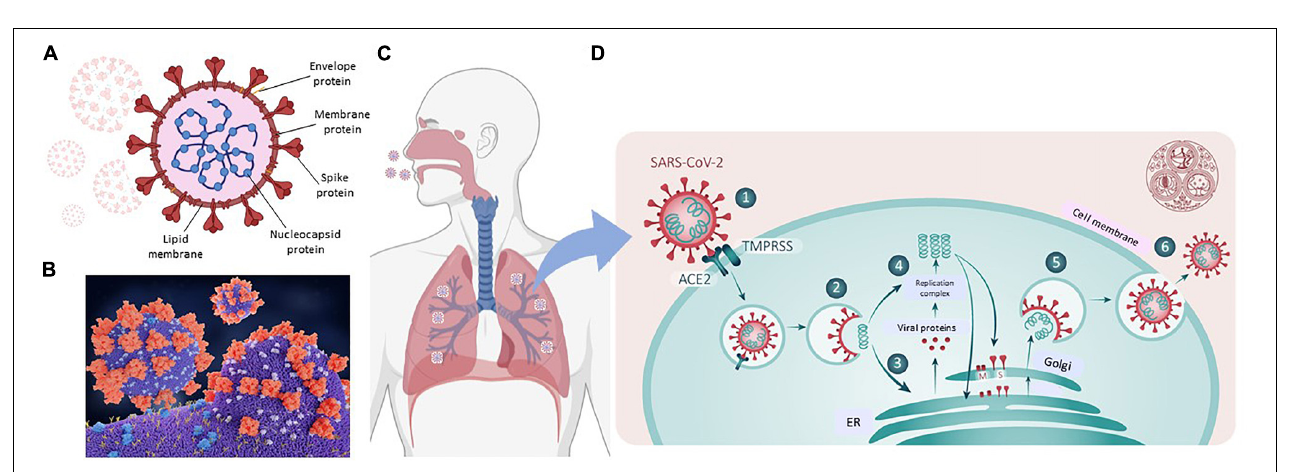
FIGURE 1 | Sex differences and COVID19. (A) Clinical pathway from confirmed cases, intensive care unit (ICU) admissions and deaths from COVID19. Data from countries providing sex-disaggregated data in October 2020. Redrawn from Global health 5050 at https://globalhealth5050.org/wp-content/uploads/October-2020- The-COVID-19-Sex-Disaggregated-Data-Tracker-Update.pdf, accessed October 16th 2020. (B) Covid19 deaths by country and sex, in March 2020. Chart from Statista at: https://www.statista.com/chart/21345/coronavirus-deaths-by-gender/. (C) deaths from COVID19 grouped by age and sex. Data obtained from 12 countries in May 2020. Redrawn from Global health 5050.